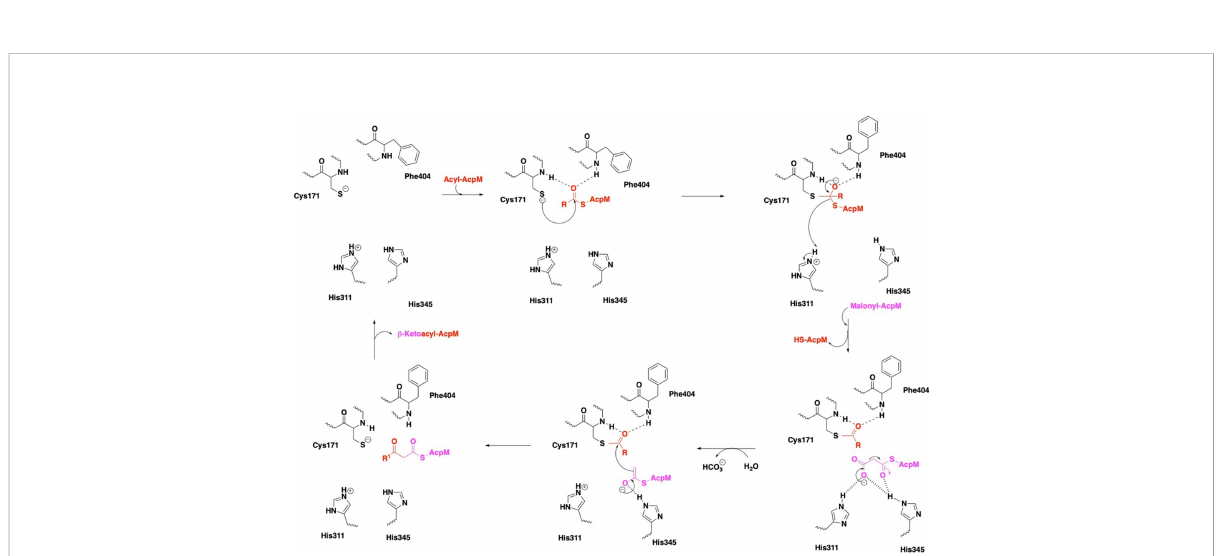
FIGURE 4 Mechanism of KasA catalysis with emphasis on the catalytic triad. In the KasA resting state, Cys171 and His311 are proposed to be deprotonated and protonated, respectively. Acylation of KasA occurs by nucleophilic attack of Cys171 on the acyl-AcpM. Several theories have been offered to explain the decarboxylation step, and it is unclear as to the protonation state of His311. The ensuing condensation of this enolate with the Cys171 bound acyl moiety occurs to elongate the acyl chain length by two carbons and then release the product.